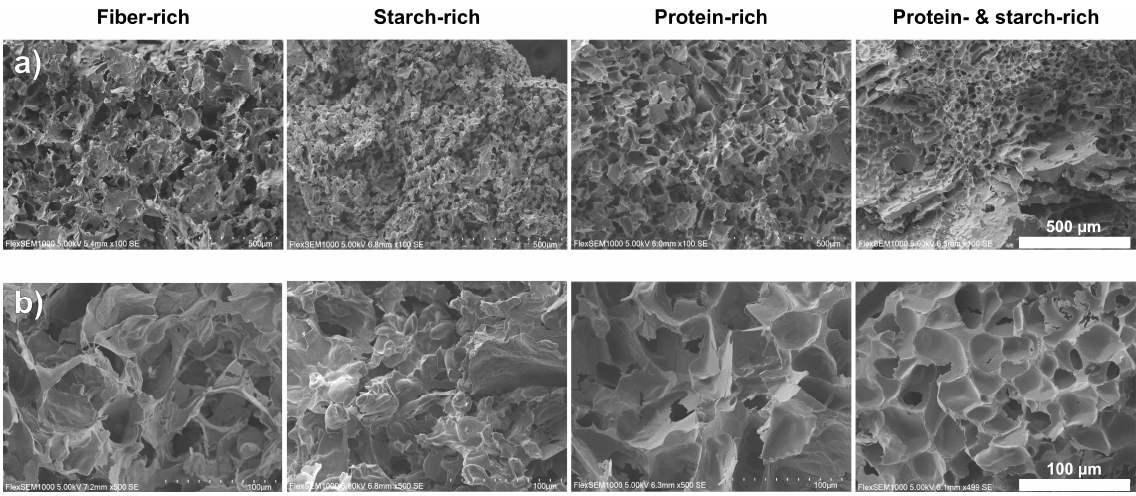
Figure 5. SEM micrographs of the fracture surface of freeze-dried printed samples at different magnification ( a , b ). Scale bar ( a ): 500 μ m (0.992 μ m/pixel), ( b ): 100 μ m (0.198 μ m/pixel).